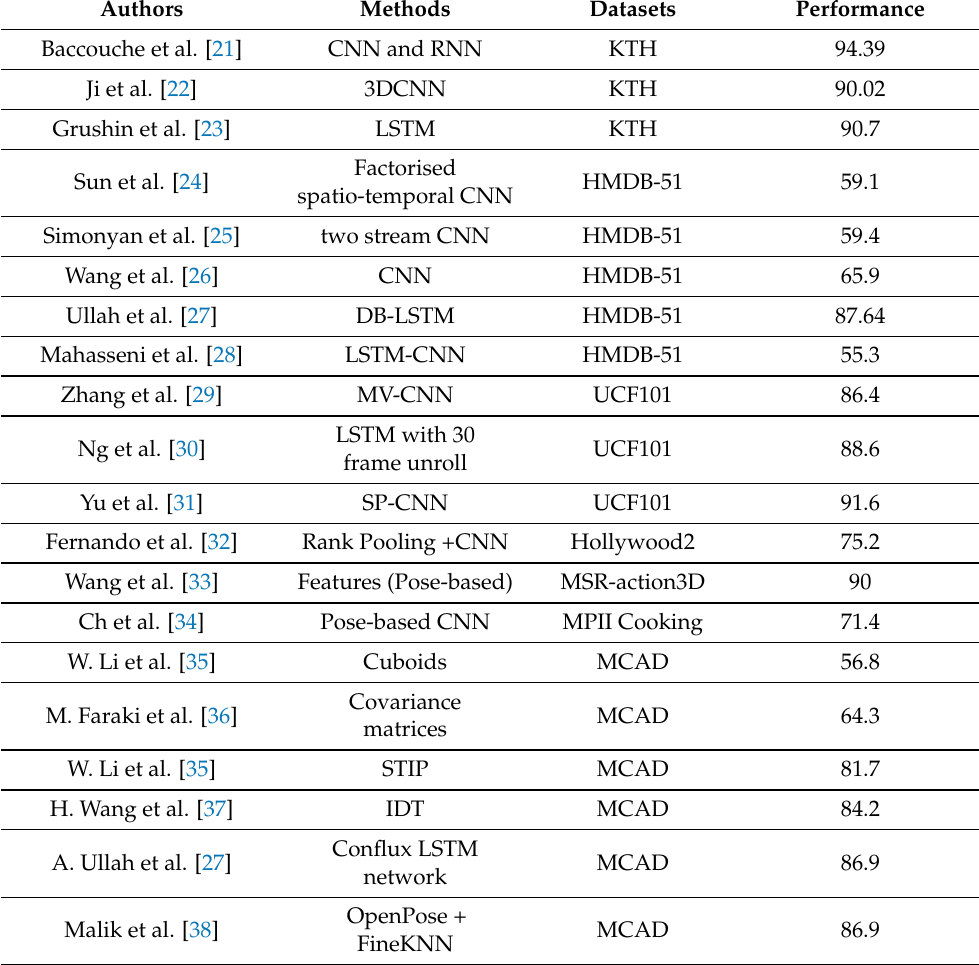
Table 1. Review on Deep learning-based techniques for Human Action Recognition.